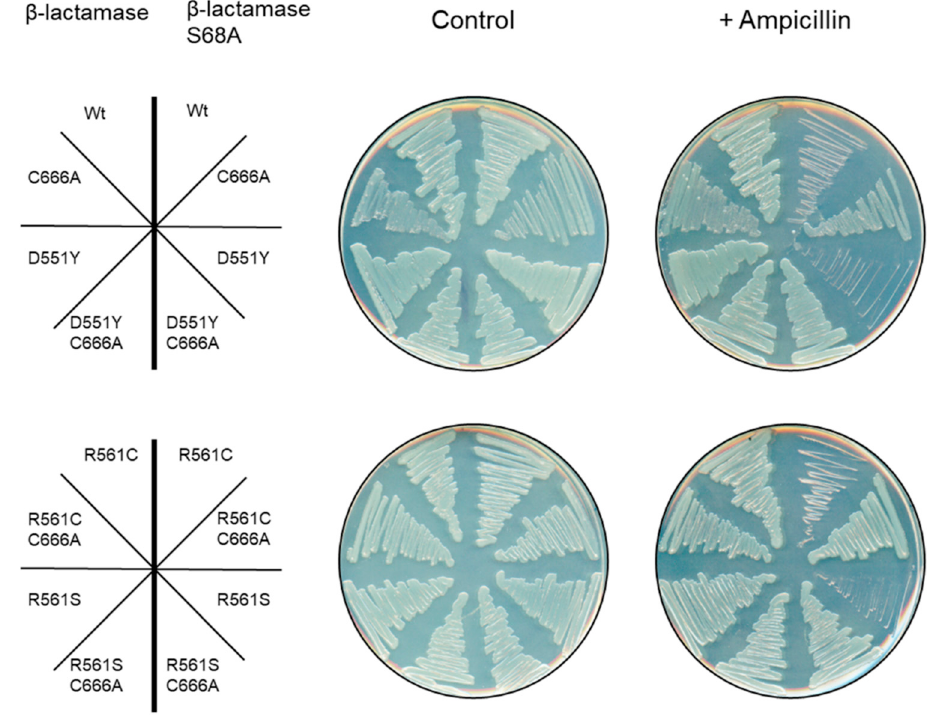
Figure 3. AlaRS C666A second-site suppressors do not prevent mistranslation. Serine mistranslation was observed in the AlaRS C666A suppressors using a β -lactamase S68A mistranslation reporter.